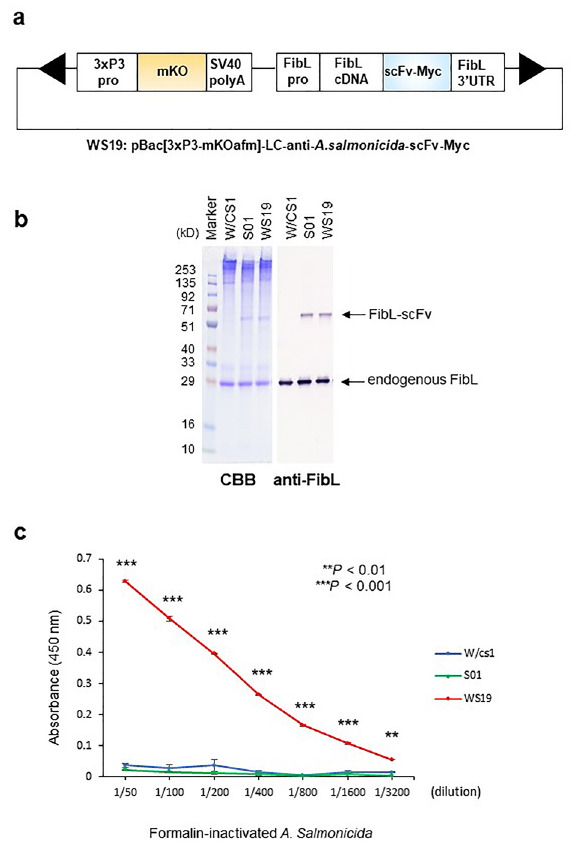
Figure 2. Construction of plasmid and production of affinity silk protein from transgenic silkworms. ( a ) Schematic representation of the DNA plasmids for WS19 transgenic silkworm strain. The plasmid contains expression units for the selection marker and recombinant protein between the piggyBac repeated terminal sequences (arrowheads). The 3xP3 promoter (3xP3pro), monomeric Kusabira-Orange gene (mKO), SV40 polyA signal sequence, fibroin L-chain promoter (FibLpro), cDNA of fibroin L-chain (FibL cDNA), the cDNA of anti- As -scFv fused with a Myc-tag sequence (scFv-Myc), and fibroin L-chain 3 ′ -untranslated region (FibL- 3’UTR) are shown. ( b ) SDS-PAGE and Western blotting of the expression of transgenes FibL-anti- As -scFv-Myc (WS19) and control FibL-anti-WASP-scFv-Myc (S01) in the silk solution. Silk solutions derived from wild- type (W/cs1), S01, and WS19 strains were separated by SDS-PAGE and stained with Coomassie brilliant blue. Immunoblots were probed with an anti-FibL polyclonal antibody. The molecular weights of endogenous